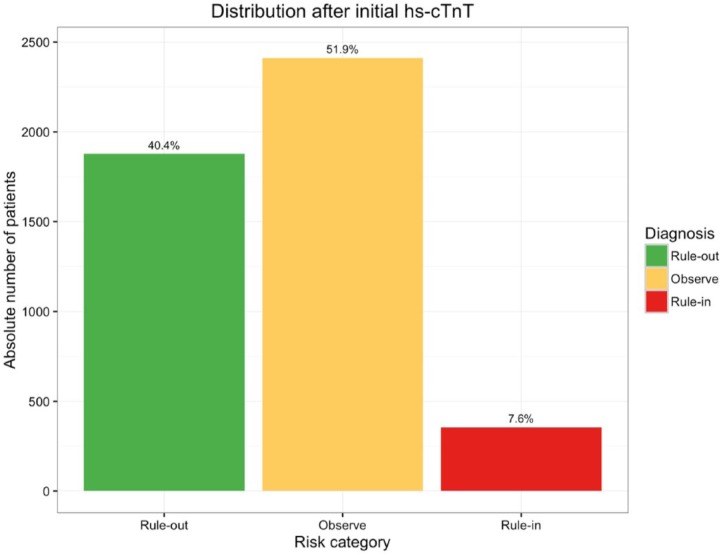
Graph outlining the distribution of all high-sensitivity troponin T (hs-cTnT) values measured on patients presenting to the Emergency Department during the monitoring period (September 2015–March 2016; n=4644); the following thresholds applied: <5 ng/l ‘rule-out’, 5-50 ng/l ‘observe’, >50 ng/l ‘rule-in’.